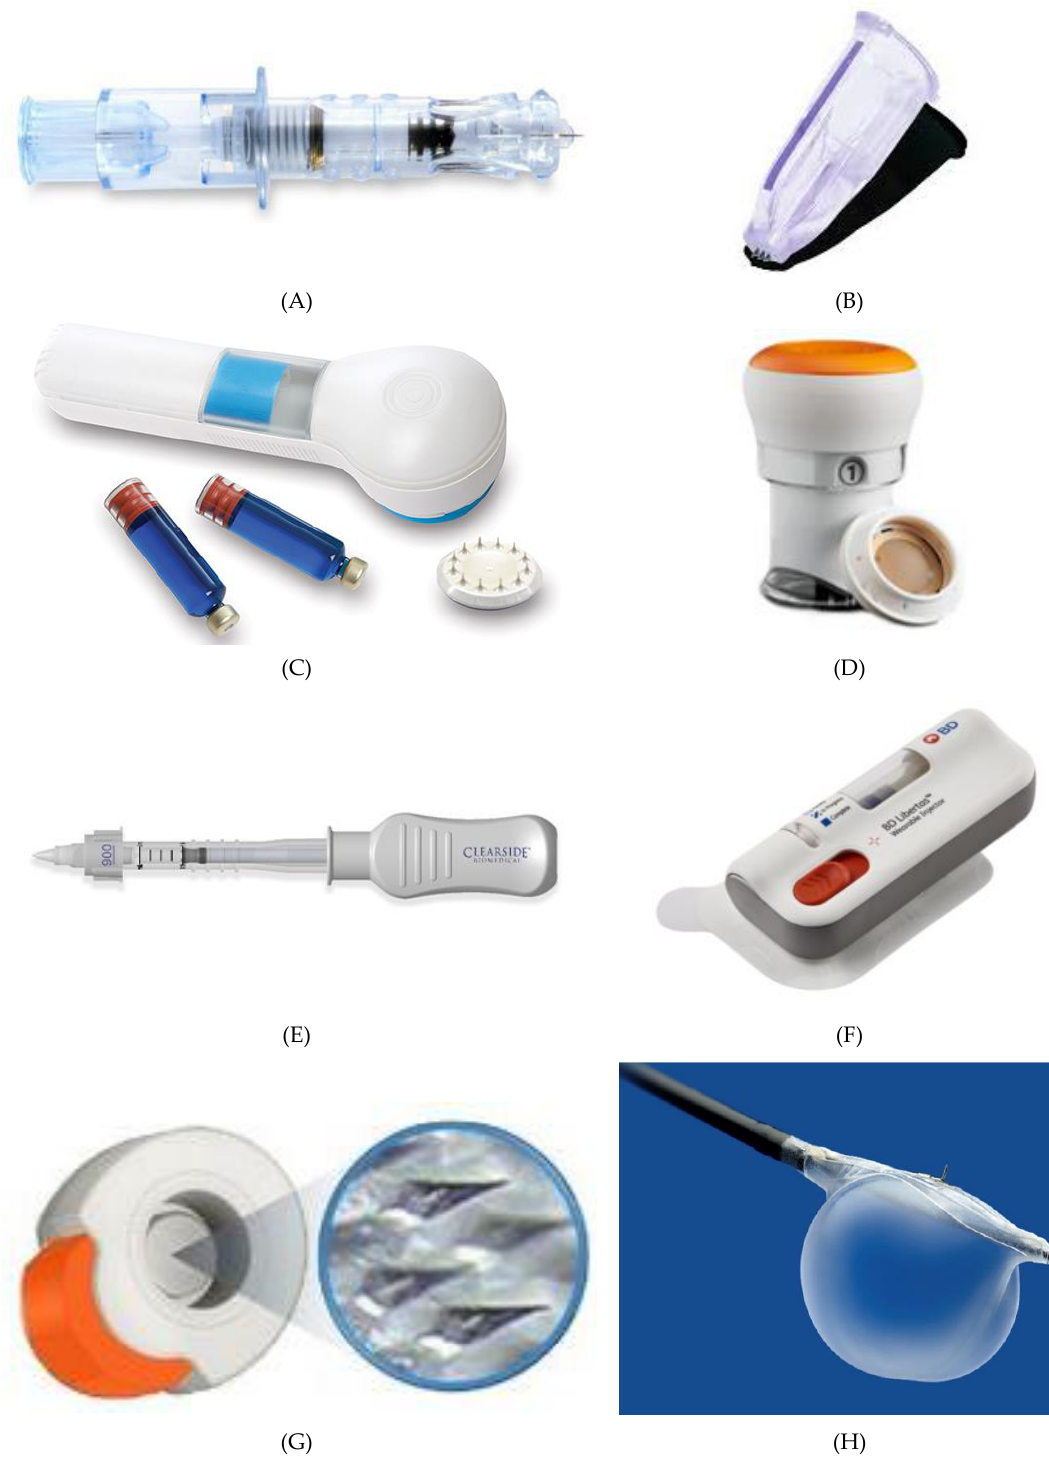
Figure 10. Current MN devices. ( A ) Soluvia ® , ( B ) MicronJet ® 600, ( C ) Microstructured Transdermal System ® , ( D ) Qtrypta™, ( E ) SCS Microinjector ® , ( F ) Microinfusor ® , ( G ) MicroCor ® , ( H ) Bullfrog ® Micro-Infusion Device.